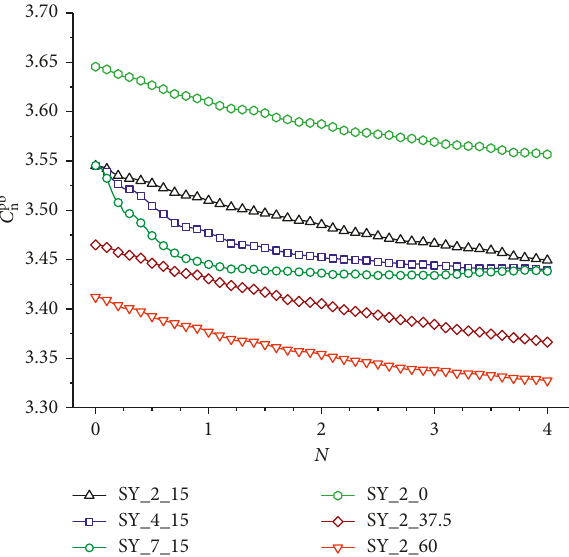
Figure 25: Evolution of the coordination number for parallel bonds ( C pb n